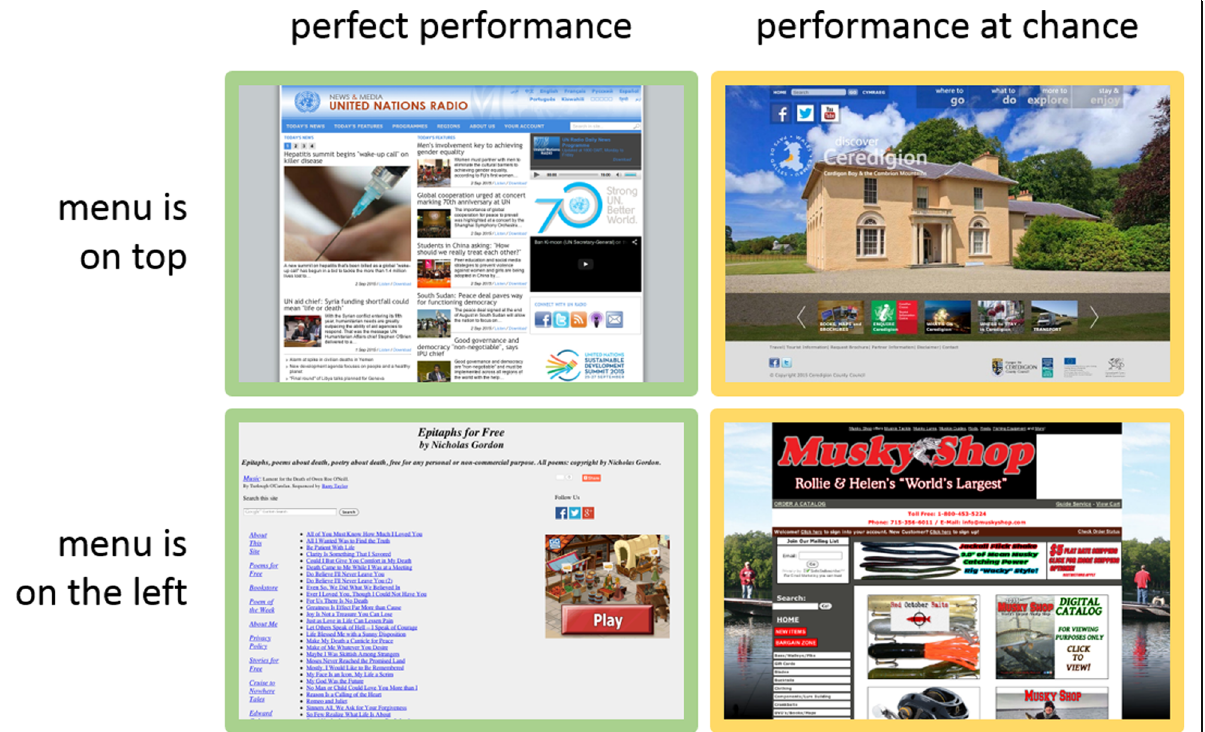
Fig. 10 Examples of menu-localization stimuli. These example web pages contain a menu either along the top (top row) or left (bottom row), and are taken from Experiment 3, where observers had to localize the menu. The left column (green outline) shows web pages for which all 10 observers found the correct location of the menu. The second column (yellow outline) shows examples of web pages for which only half (5) of the observers were